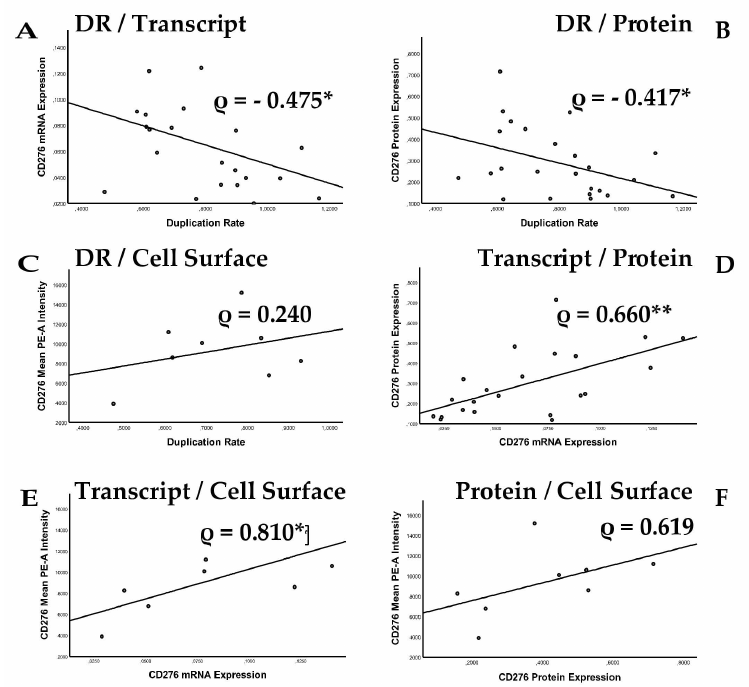
Figure 4. Correlation of CD276 expression with cell proliferation. Expression of CD276 was correlated on ( A ) transcript levels with cell duplication rates, ( B ) protein levels with duplication rates, ( C ) cell surfaces with duplication rates, ( D ) transcript versus protein levels, ( E ) transcript versus cell surface levels, and ( F ) protein versus cell surface levels. While the expression of CD276 transcript and protein yielded a negative correlation with proliferation, all other correlations were positive. Statistical significance is indicated (*,